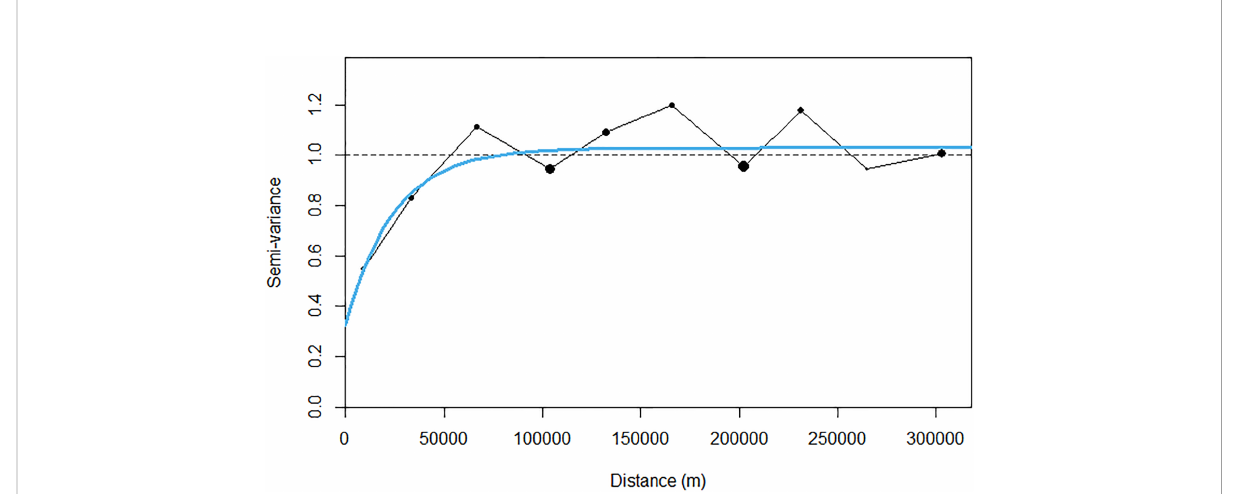
FIGURE 9 Experimental back transformed (black dots) and modelled (solid blue line) variogram of s A for